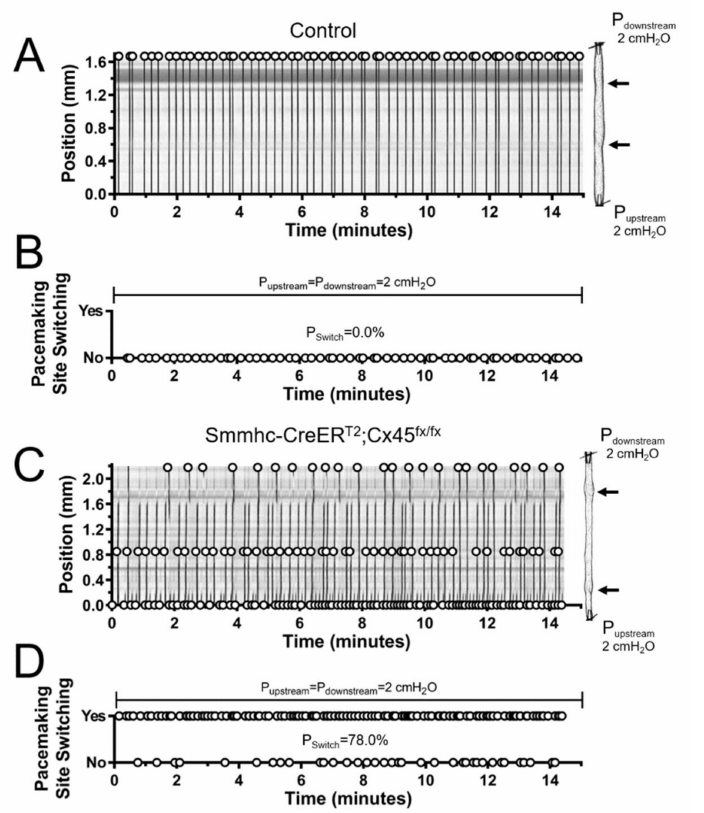
Figure 4. Pacemaking activity in lymphatic vessels from control (C57BL / 6J WT and Cx45 fx / fx ) and smooth-muscle Cx45-deficient (Smmhc-CreER T2 ;Cx45 fx / fx ) mice under control intraluminal pressure (P upstream = P downstream = 2 cmH 2 O): ( A , C ) STMs of contractions of popliteal lymphatic vessels